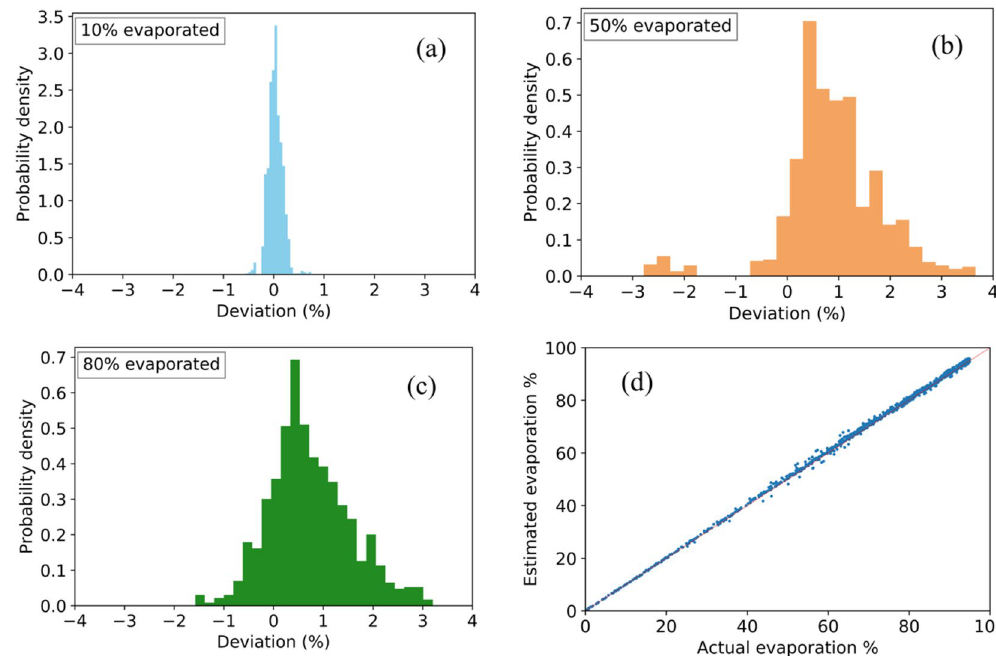
Figure 3. Performance of ANNs for predicting the degree of evaporation for samples evaporated up to ( a ) 10%, ( b ) 50%, and ( c ) 80% at 298.15 K. The deviation percentage is defined as the difference between the actual degree of evaporation and the estimated degree of evaporation by the ANN. ( d ) Scatterplot of the actual evaporation percentage and the evaporation percentage estimated by the ANN model. The data points correspond to degrees of evaporation between 0 w% and 95